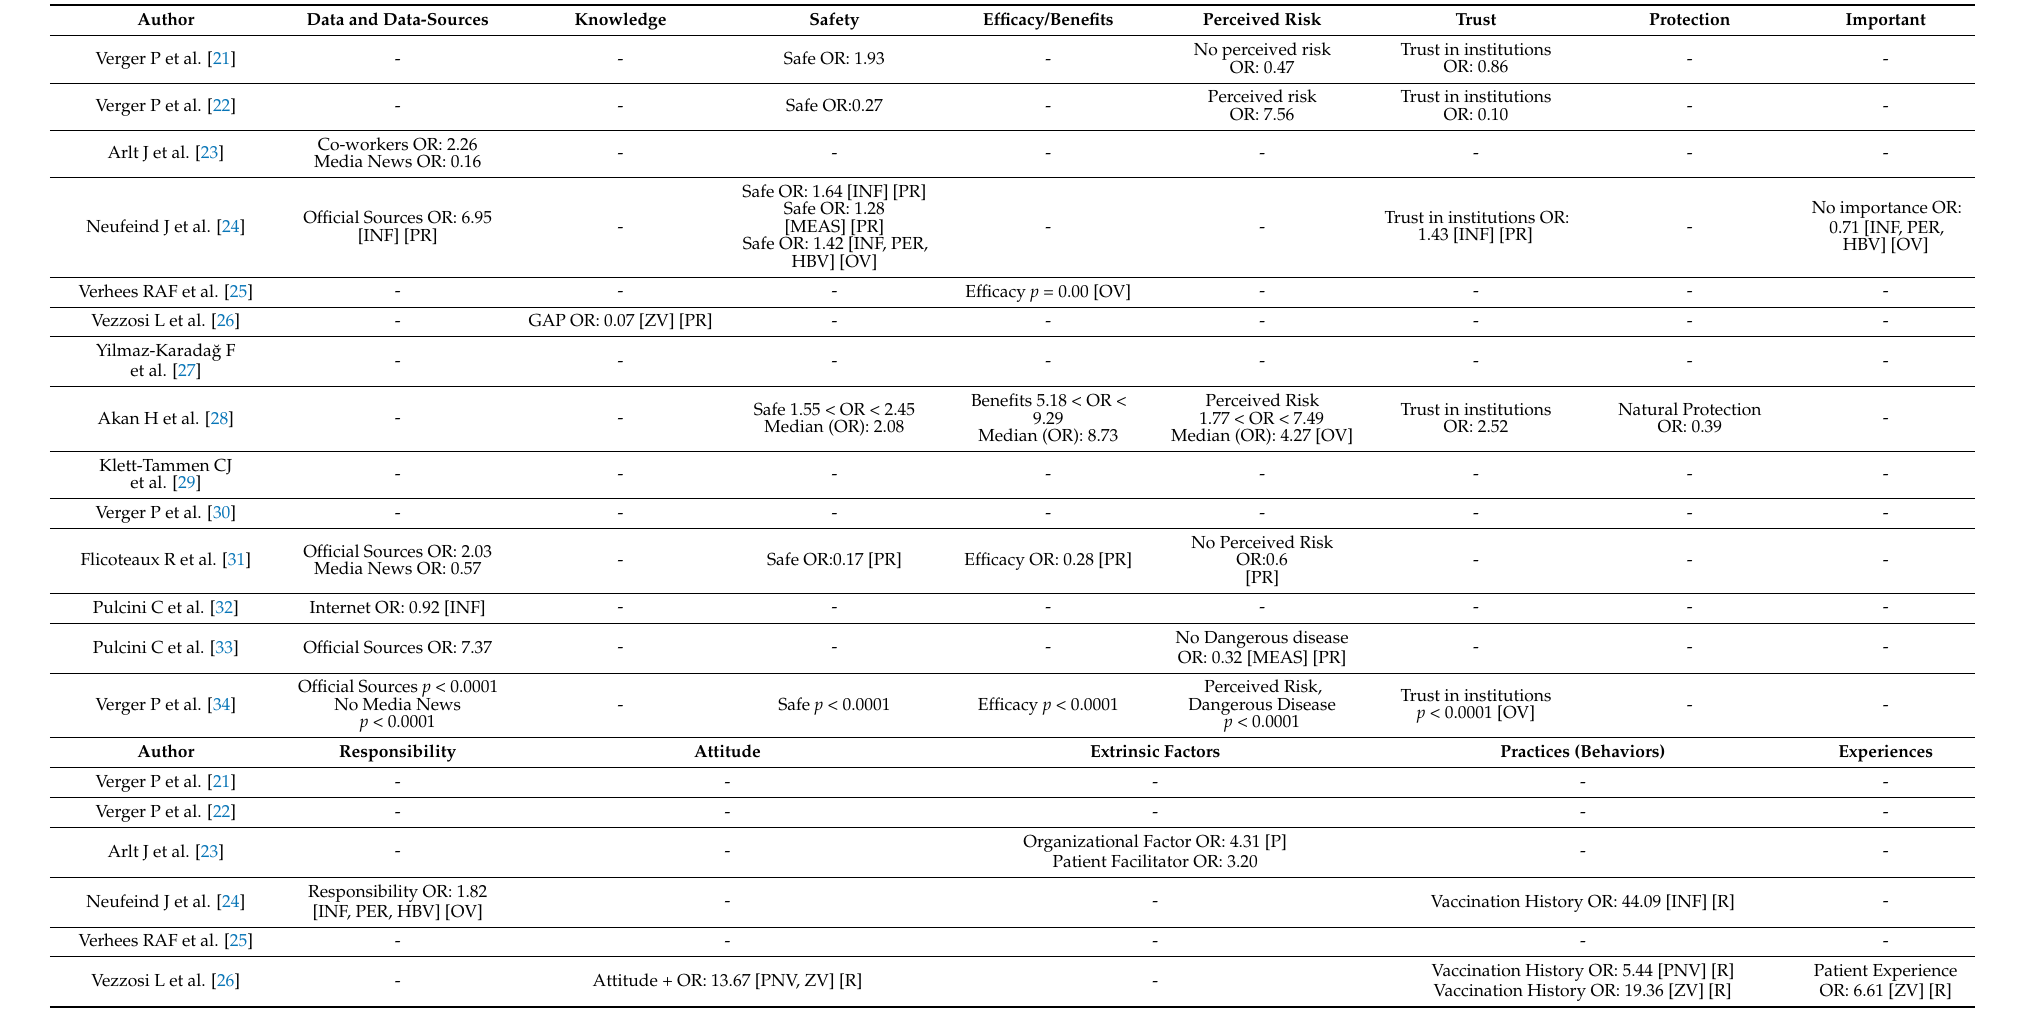
Table 3. Intrinsic and extrinsic factors reported by each study and their influence on